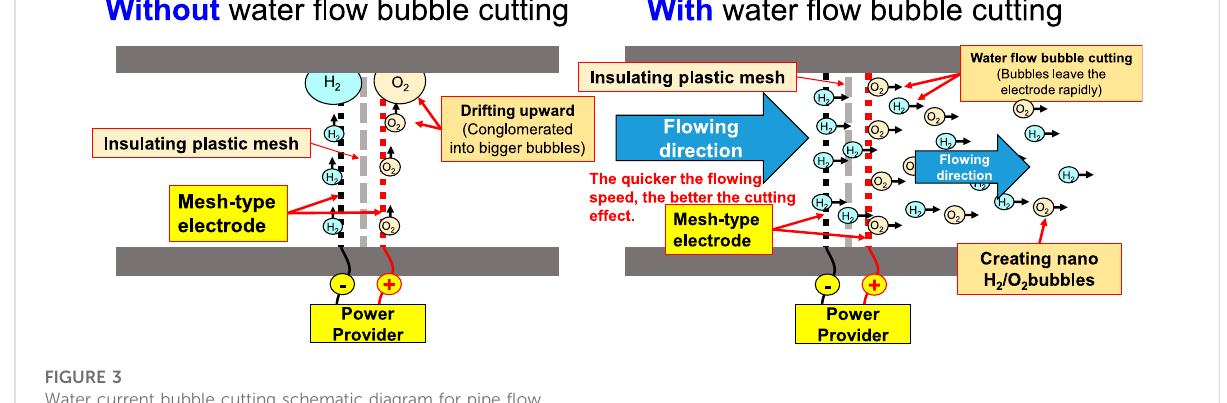
FIGURE 3 Water current bubble cutting schematic diagram for pipe fl